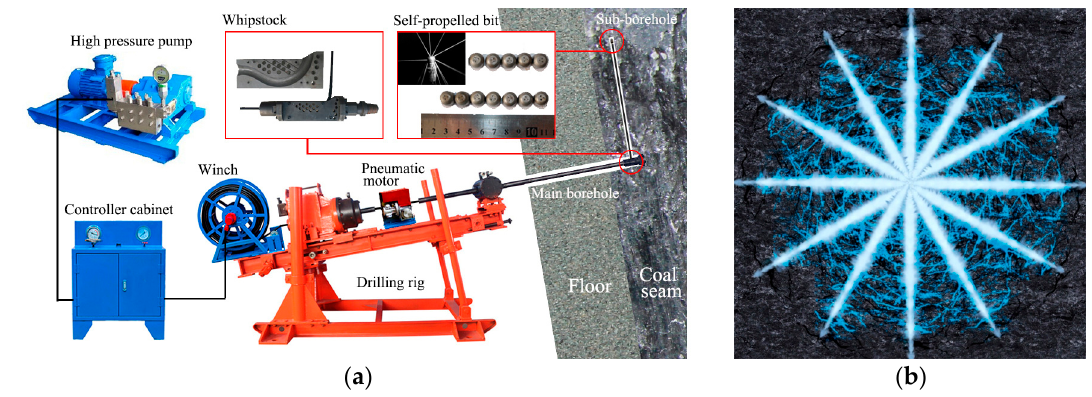
Figure 1. Illustrations showing ( a ) the equipment used for tree-type drilling and fracturing for gas drainage in underground coal mines and ( b ) tree-type sub-boreholes and the fractures propagated from them.